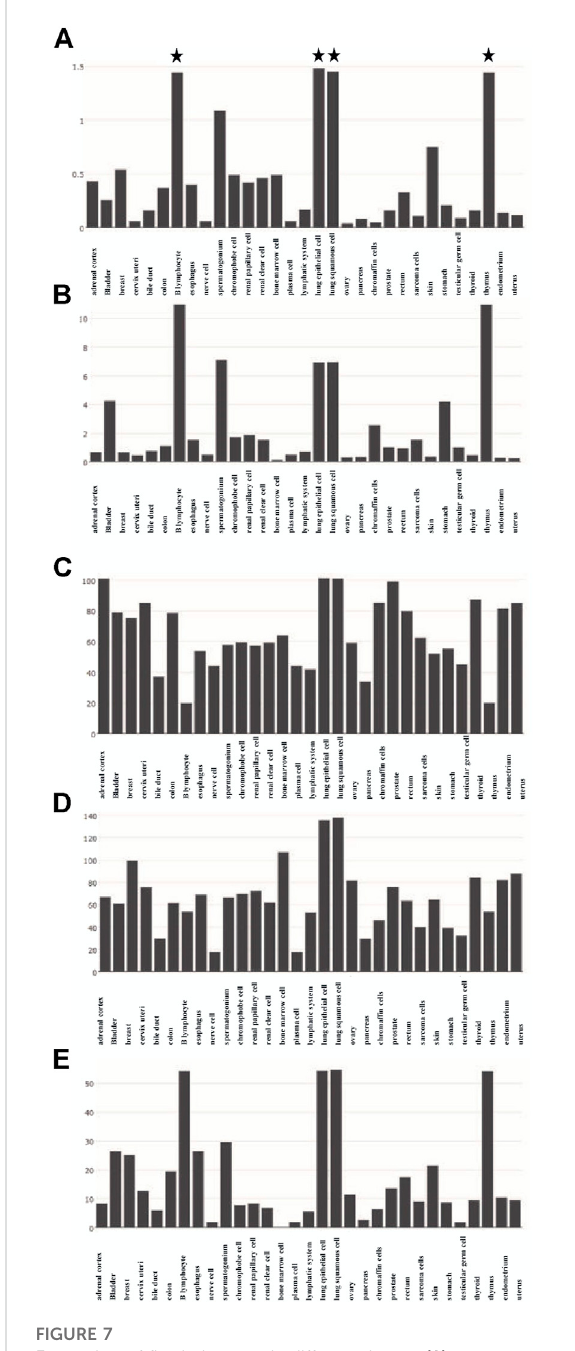
FIGURE 7 Expression of fi ve hub genes in different tissues. (A) Expression of TNF in different tissues. (B) Expression of IL-1B in different tissues. (C) Expression of AKT1 in different tissues. (D) Expression of CASP1 in different tissues. (E) Expression of STAT3 in different